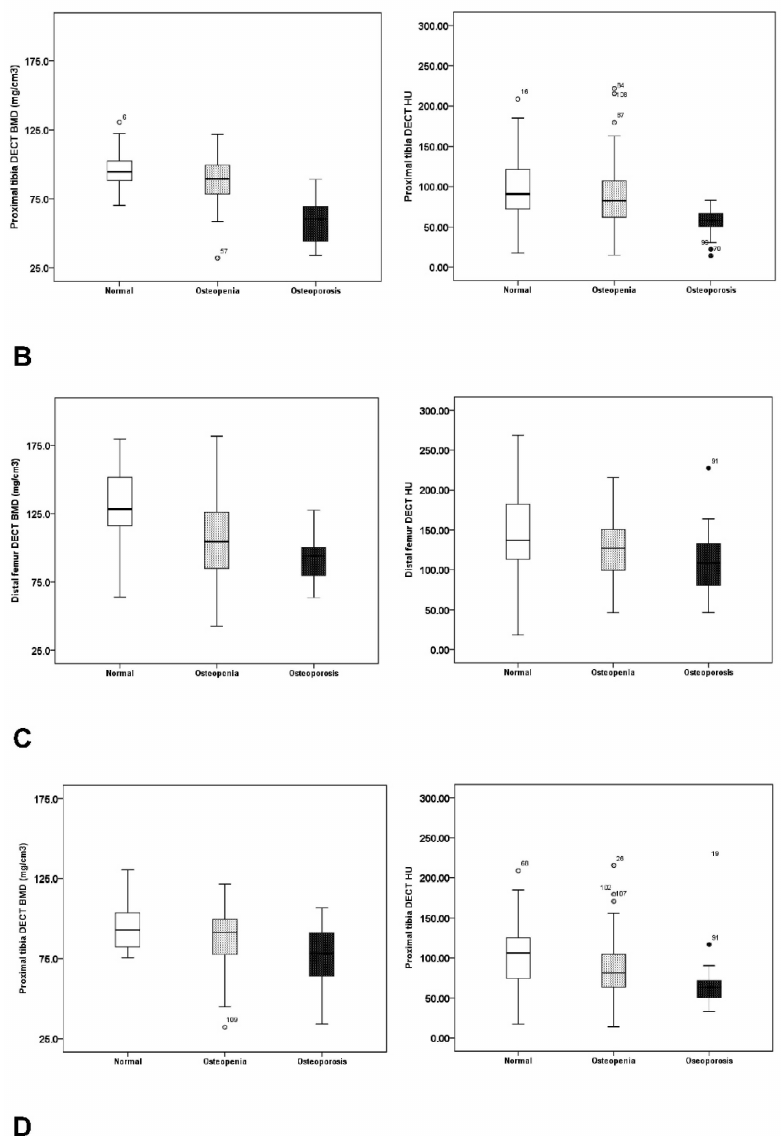
Figure 3. ( A ) Box plots of volumetric bone mineral density (BMD) and Hounsfield unit (HU) values in the distal femur derived from dual-energy computed tomography (DECT). The plots show the distribution of values that were categorized as normal BMD, osteopenia, and osteoporosis according to the dual x-ray absorptiometry (DXA)-derived T-score in the lumbar spine, which served as the reference standard; ( B ) Box plots of volumetric bone mineral density (BMD) and Hounsfield unit (HU) values in the proximal tibia derived from dual-energy computed tomography (DECT). The plots show the distribution of values that were categorized as normal BMD, osteopenia, and osteoporosis according to the dual x-ray absorptiometry (DXA)-derived T-score in the lumbar spine, which served as the reference standard; ( C ) Box plots of volumetric bone mineral density (BMD) and Hounsfield unit (HU) values in the distal femur derived from dual-energy computed tomography (DECT). The plots show the distribution of values that were categorized as normal BMD, osteopenia, and osteoporosis according to the dual x-ray absorptiometry (DXA)-derived T-score in the femur neck, which served as the reference standard; ( D ) Box plots of volumetric bone mineral density (BMD) and Hounsfield unit (HU) values in the proximal tibia derived from dual-energy computed tomography (DECT). The plots show the distribution of values that were categorized as normal BMD, osteopenia, and osteoporosis according to the dual x-ray absorptiometry (DXA)-derived T-score in the femur neck, which served as the reference